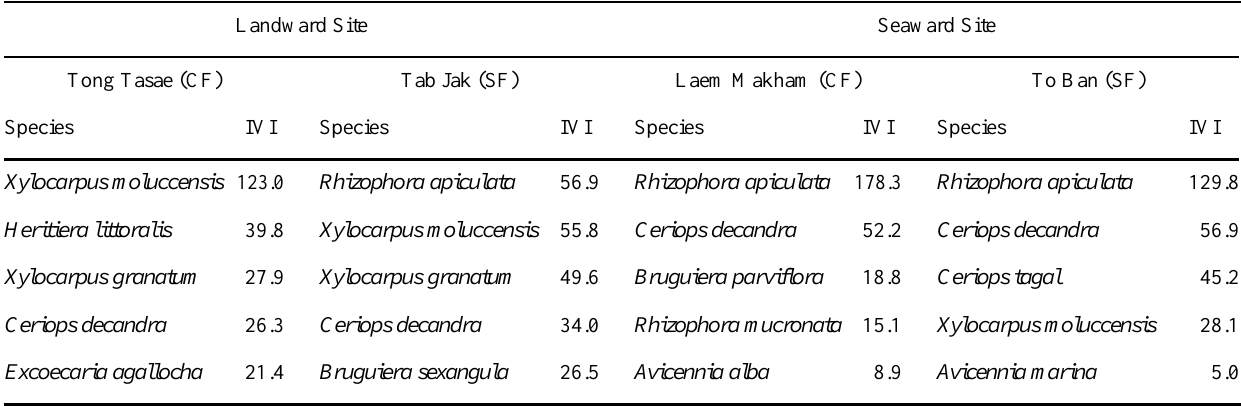
Table 4. The five most important mangrove species, ranked by Important Value Index (IVI) in two community forests (CF) and two state forests (SF) in Trang, southern